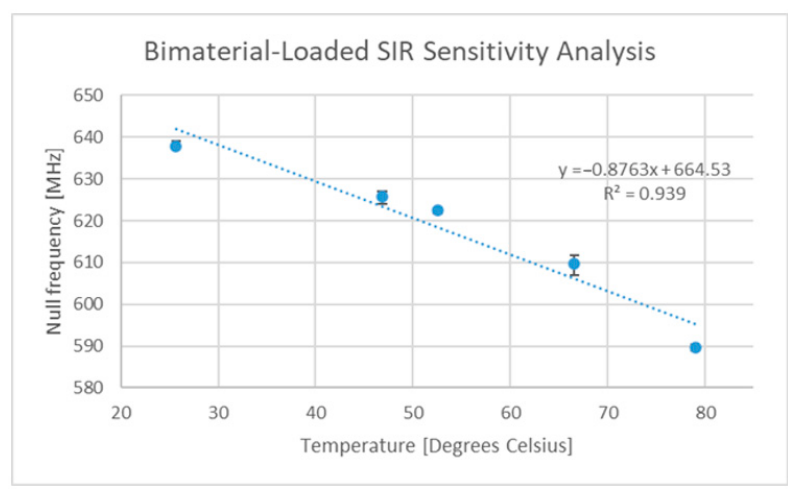
Figure 12. FR4 SIR circuit with cantilever temperature sensitivity curve.